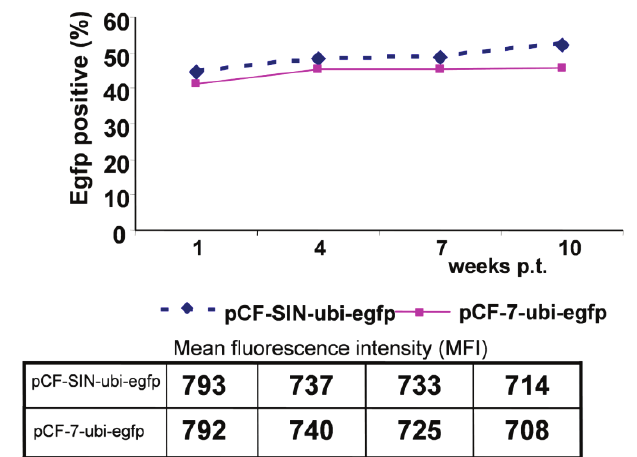
Figure 2. Stable egfp expression in ubi-egfp vector-transduced Crandall-Rees feline kidney (CRFK) cells. Stability of transgene expression is expressed as the percentage of Egfp-positive cells (top panel) and the mean fluorescence intensity (MFI, bottom panel). CRFK cells were transduced with pCF-SIN-ubi-egfp and pCF-7-ubi-egfp at a multiplicity of infection (MOI) of 0.5. Transduced cells were passaged twice weekly and analyzed by flow cytometry every three weeks post-transduction. Quantitative results are given by the percentage of Egfp-positive cells and the MFI as a marker for the expression level, according to each flow cytometry